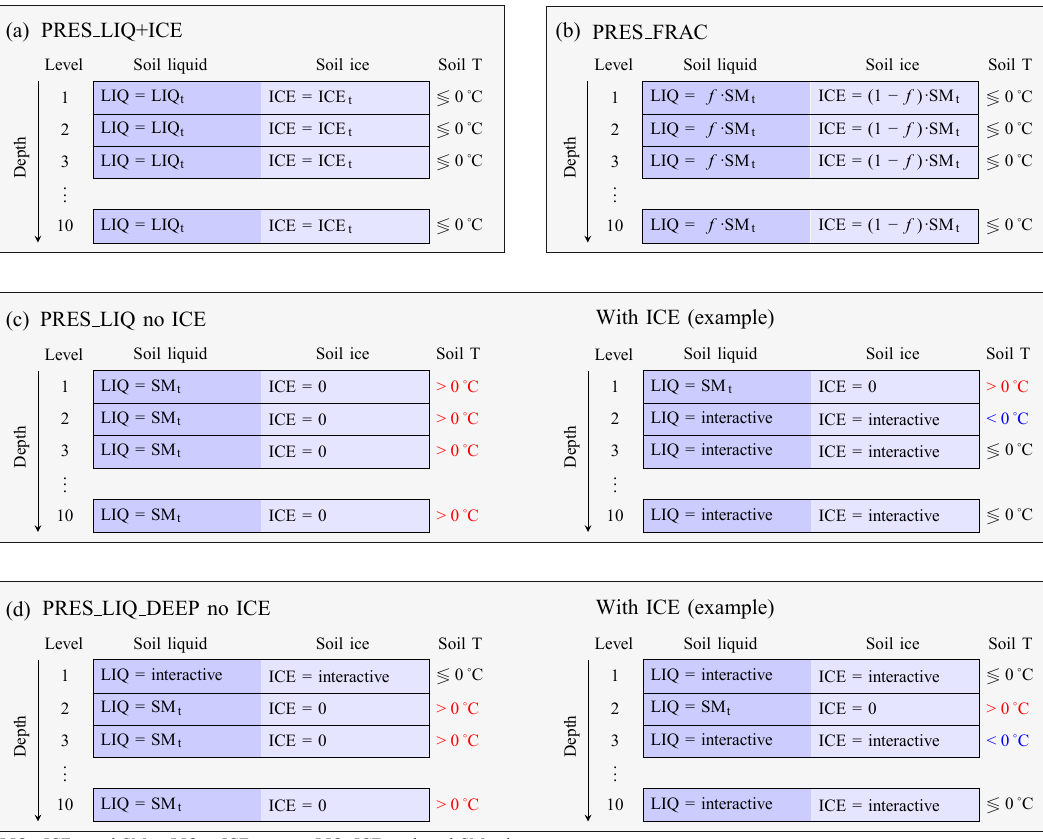
Figure 1. The four tested approaches to prescribe SM in CLM. The target LIQ, ICE, and SM values are denoted LIQ t , ICE t , and SM t , respectively. SM t corresponds to the sum of LIQ t and ICE t (i.e. SM t = LIQ t + ICE t ). In general the target values depend on time (day of year), location (grid point), and depth (soil level). In this study we use the 30-year-mean and 30-year-median seasonal cycle; however, other targets are possible, e.g. a specific year. (a) LIQ and ICE are both prescribed in PRES_LIQ+ICE. (b) In PRES_FRAC, total SM is prescribed, but the fraction f = LIQ /( LIQ + ICE ) is interactively computed by the model. Note that the hydrology in CLM4 is still active. (c) Illustration of the new approach (PRES_LIQ), prescribing LIQ in all soil levels if the soil temperature is above freezing (left) and for an example with soil level two below freezing (right). (d) PRES_LIQ_DEEP as PRES_LIQ, but the first soil layer is always